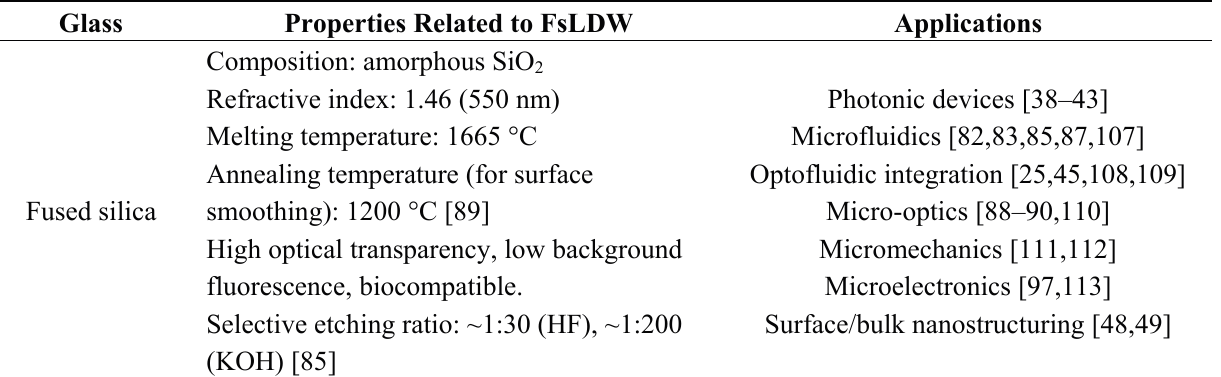
Table 1. Typical properties and applications of fused silica, Foturan glass and porous glass.